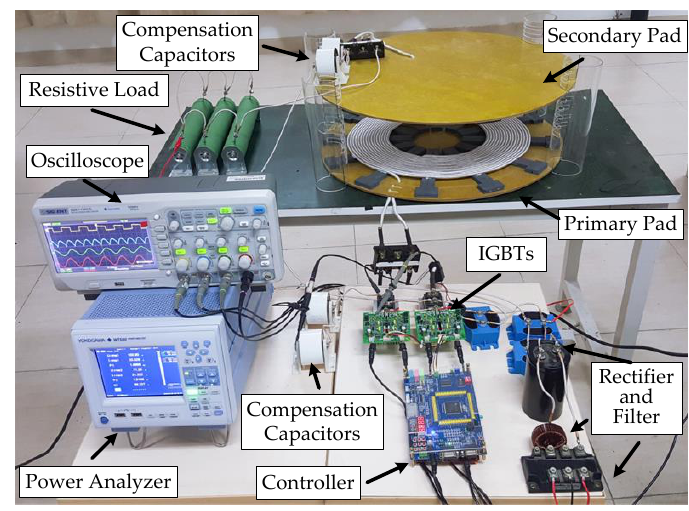
Figure 13. A 1.5 kW prototype of FRC IPT system.